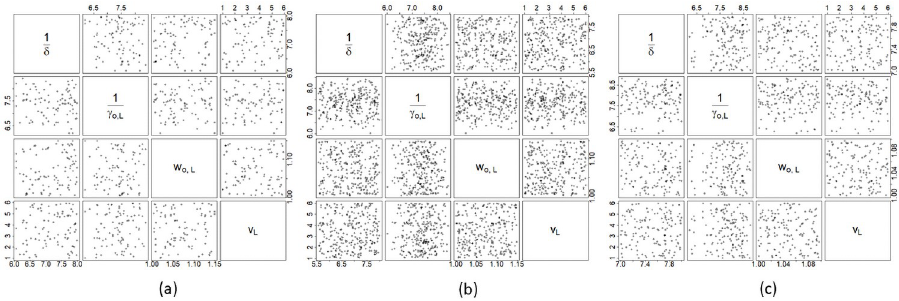
Fig 8. Correlation plots 2. Correlation plots of a different set of pairings of parameters of the modified SEIR model for (a) Malaysia, (b) Selangor and (c) Sarawak.